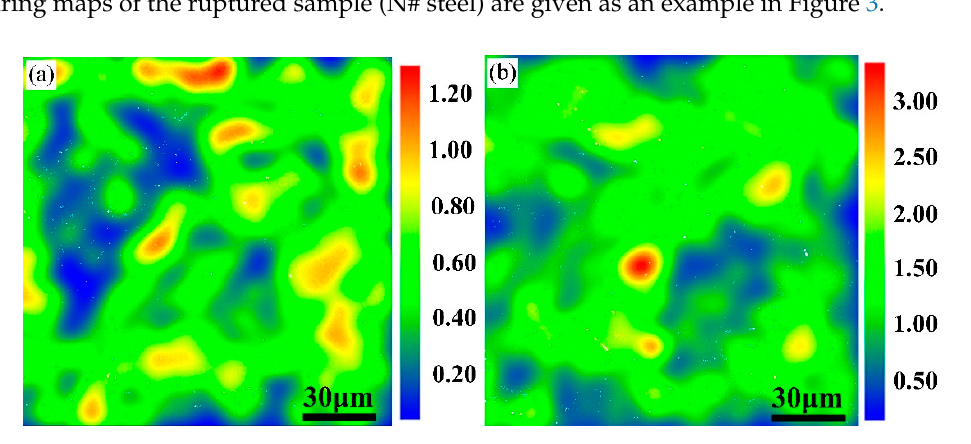
Figure 3. Strain contouring maps of N# steel ruptured sample ( a ) grip; ( b ) gauge.